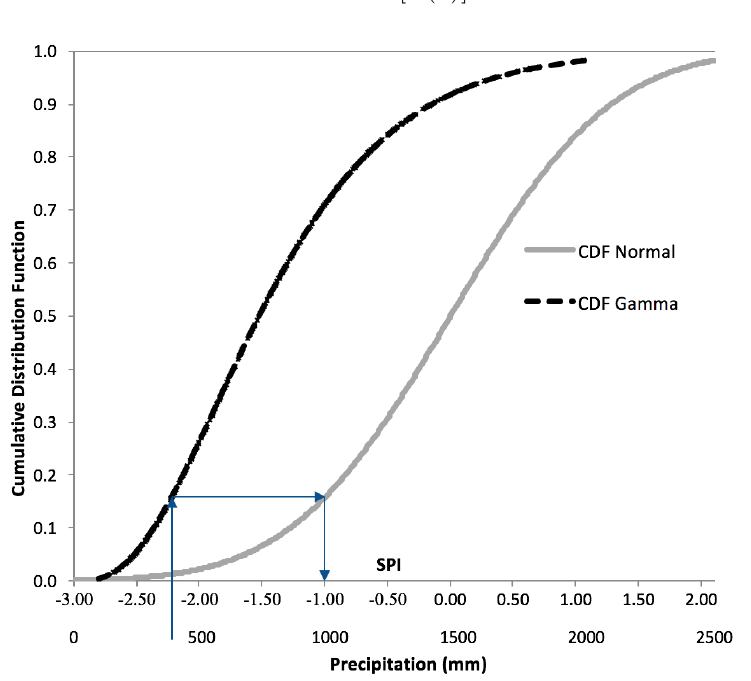
Figure 3. Transformation cumulative distribution function (CDF) gamma to CDF. Adapted from [1].